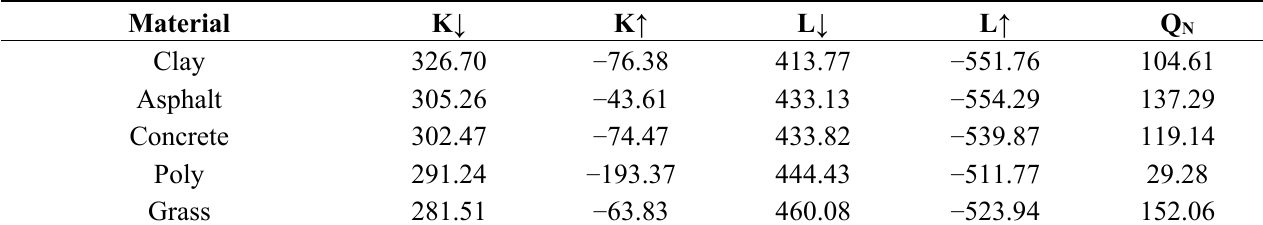
Table 2. NR01 solar components and net total radiation in W·m − 2 .